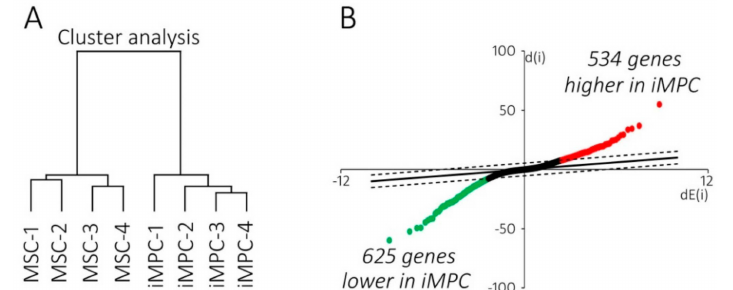
Figure 2. The gene expression profiling in iMPCs versus MSCs. The total RNA extracted at the end of passage 3 from 4 independent iMPC and MSC populations were subjected to genome-wide cDNA microarray analysis. ( A ) Cluster analysis of the sample set based on whole-genome expression data. ( B ) Significance analysis of microarrays (SAM) of global expression data depicted as scatter plot. The observed relative di ff erence d(i) was plotted against the expected relative di ff erence dE(i). The dashed lines define the di ff erence between d(i) and dE(i) beyond which genes are considered significant. The red and green points denote genes significantly higher or lower expressed in iMPC compared to MSC, respectively.